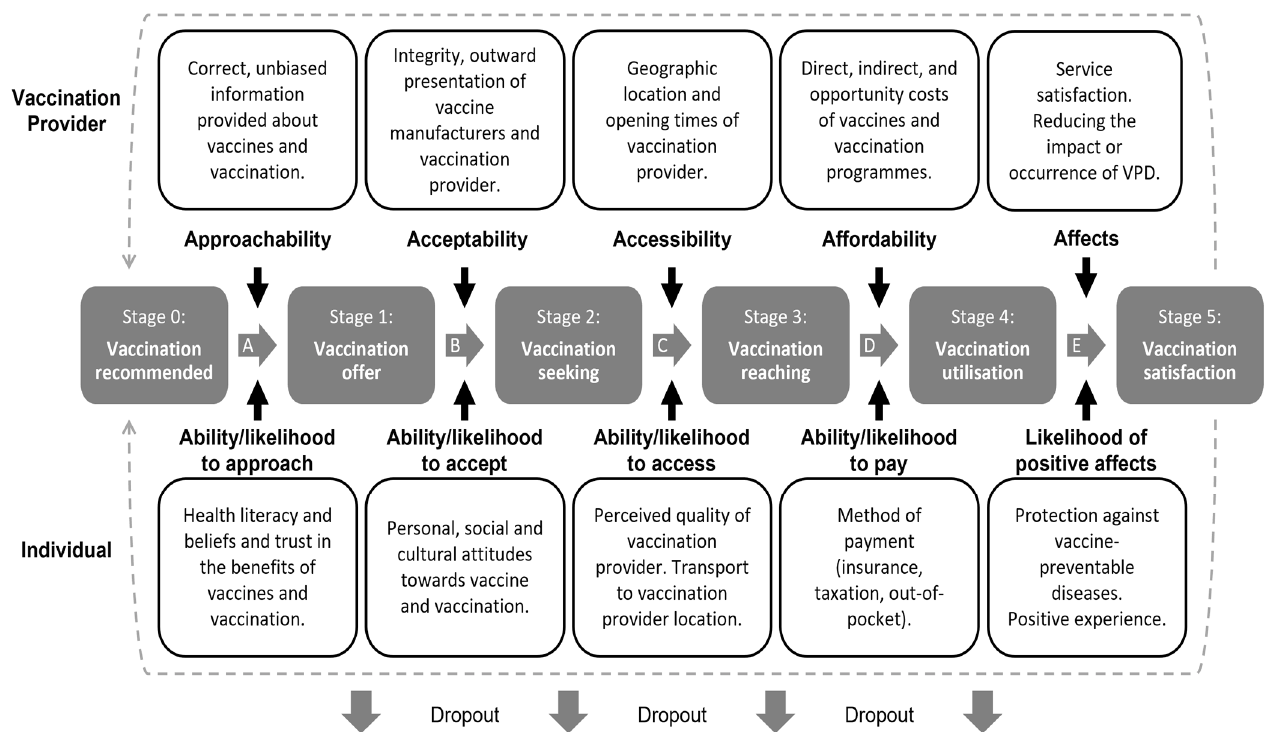
Figure 1. Illustrates the process of access to vaccinations. Adapted from Levesque et al.’s patient- centred access to healthcare framework [7].